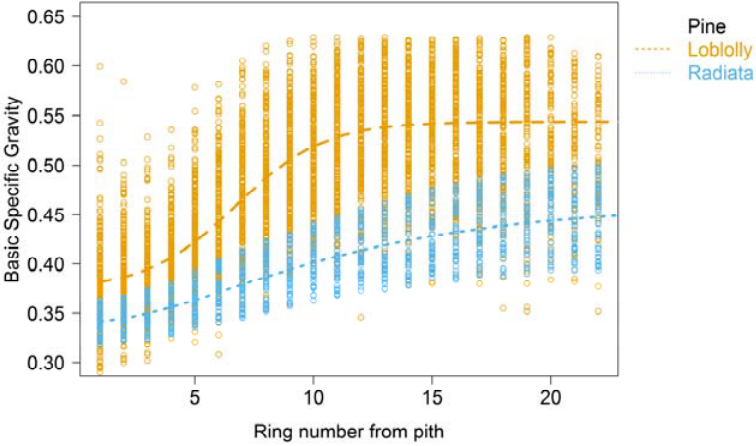
Figure 1. Plot showing the variation and mean trend in ring specific gravity (SG) from pith to bark (ring number from pith) at breast height for loblolly and radiata pine. The plot is based on a subset of